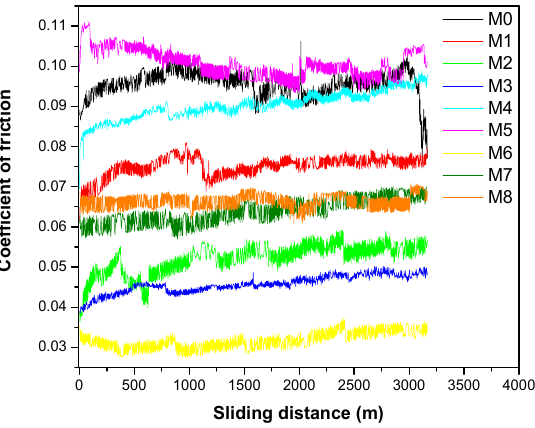
Figure 8. Variation of the coefficient of friction obtained at the surface of the employed samples.